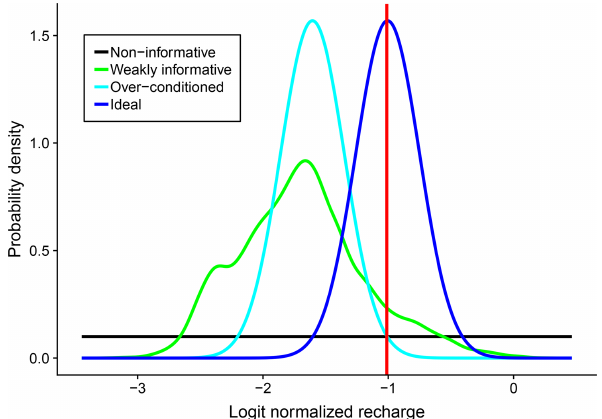
Figure 8. An example of over-conditioning: the probability den- sity at the true value (indicated by the red vertical line) of the over-conditioned distribution is not higher than that of the non- informative distribution or that of the weakly informative distribu- tion, not because the conditioning does not work, but because of the disproportional reduction of the variance of the